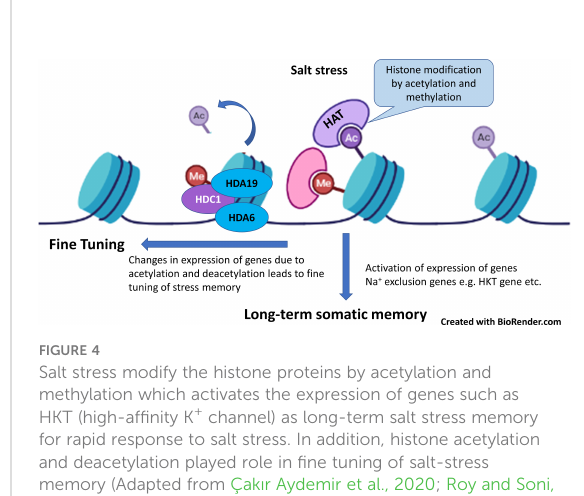
FIGURE 4 Salt stress modify the histone proteins by acetylation and methylation which activates the expression of genes such as HKT (high-af fi nity K + channel) as long-term salt stress memory for rapid response to salt stress. In addition, histone acetylation and deacetylation played role in fi ne tuning of salt-stress memory (Adapted from C ̧ ak ı r Aydemir et al., 2020; Roy and Soni,